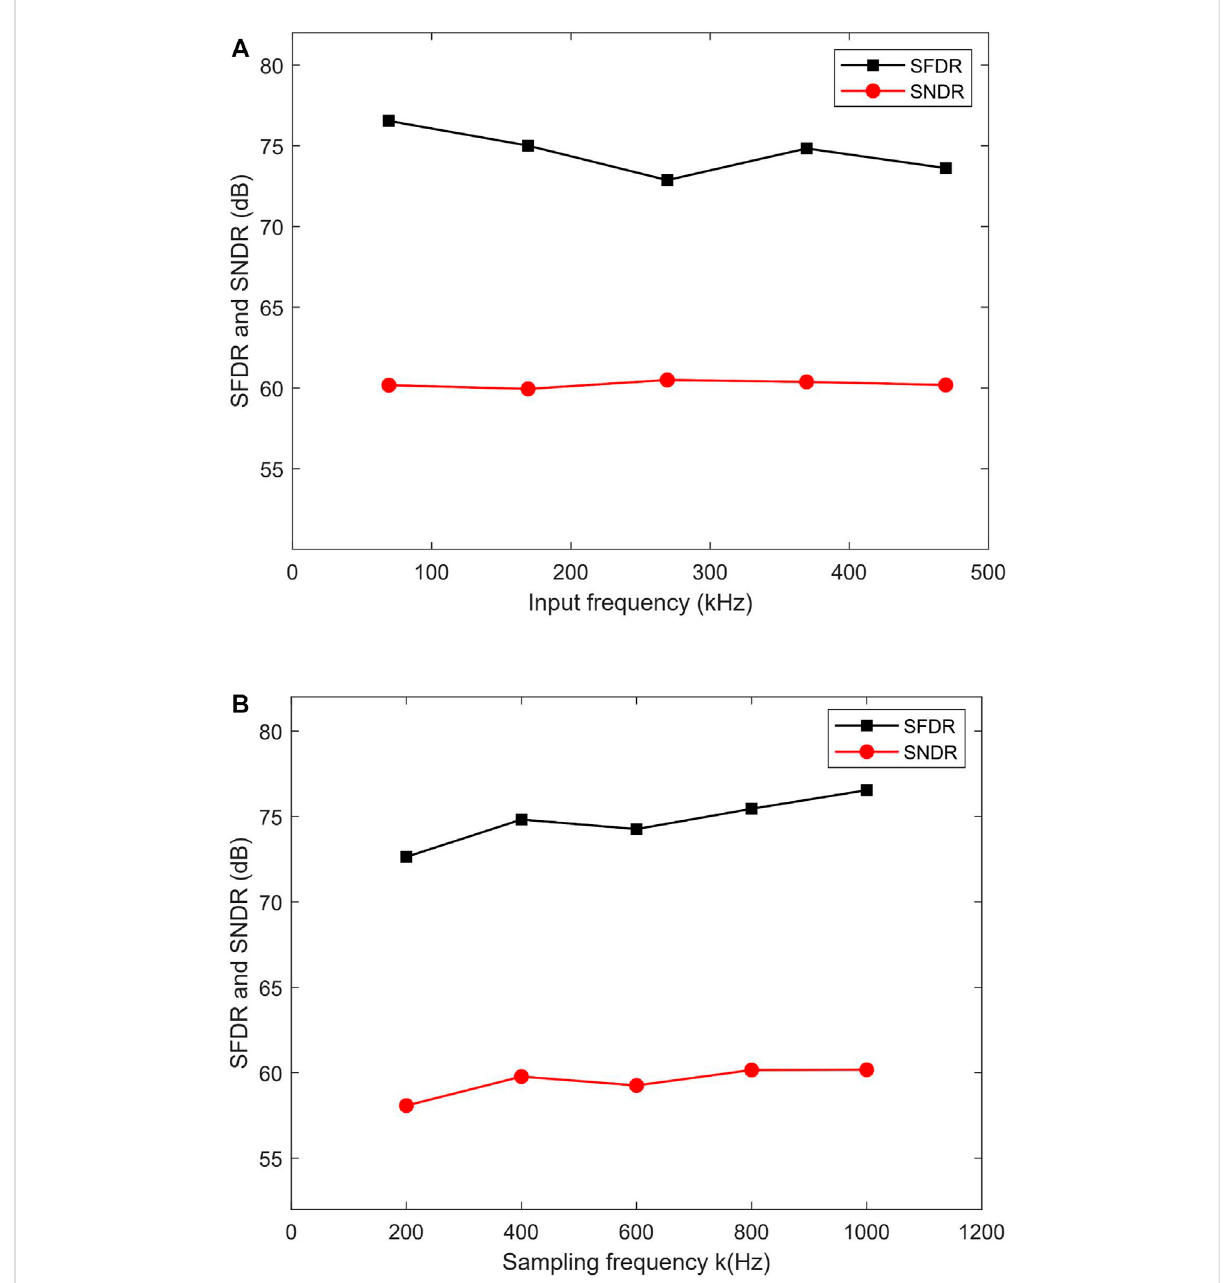
FIGURE 13 SNDR/SFDR with various input frequencies and various sampling frequencies. (A) Various input frequencies. (B) Various sampling